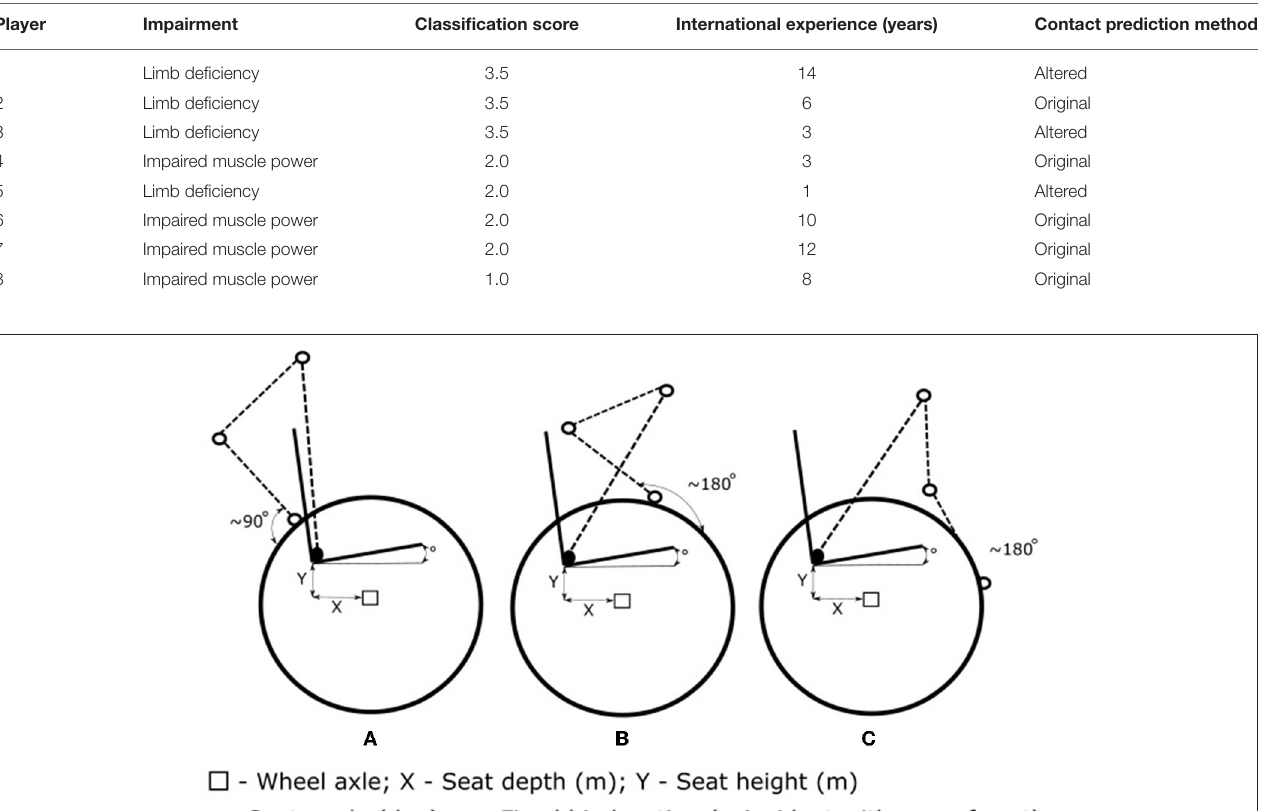
TABLE 1 | Player information, including impairment, classification, and experience information. Contact Prediction Method refers to whether these players required an alteration to the equations for calculating their kinematics (see Section Propulsion Prediction).